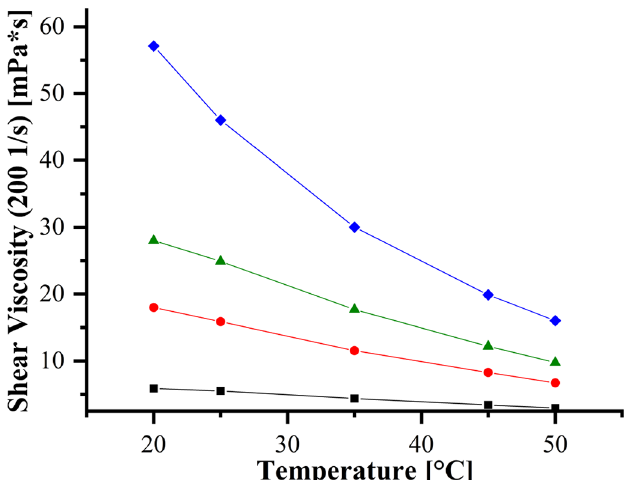
Fig. 6. Temperature dependence of shear viscosities (200 1/s) of organic phases (1.5 M DEHiBA/Isane) as a function of uranyl content. Color code: 0.60M uranyl (blue), 0.45 M uranyl (green), 0.31 M uranyl (red), 0M uranyl (black).